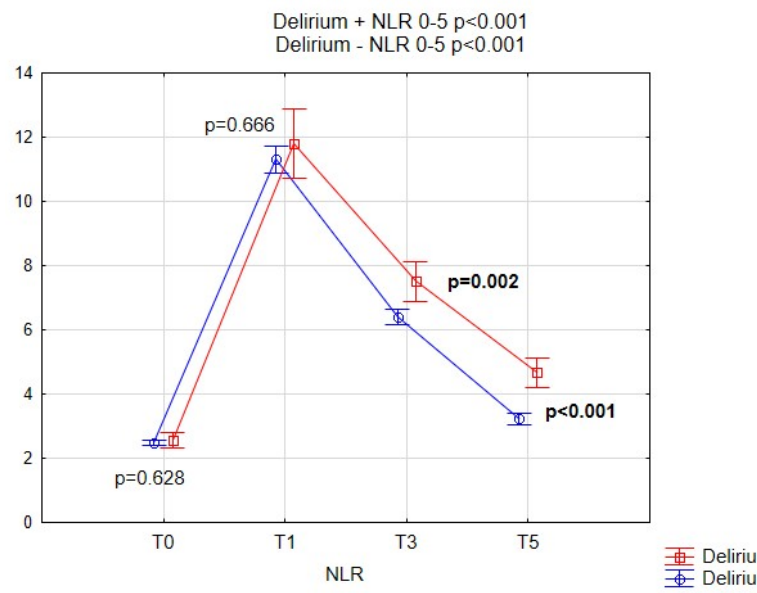
Figure 2. Pre-operative and post-operative NLR values for patients with and without POD. NLR, neutrophil-to-lymphocyte ratio; POD, Postoperative delirium.